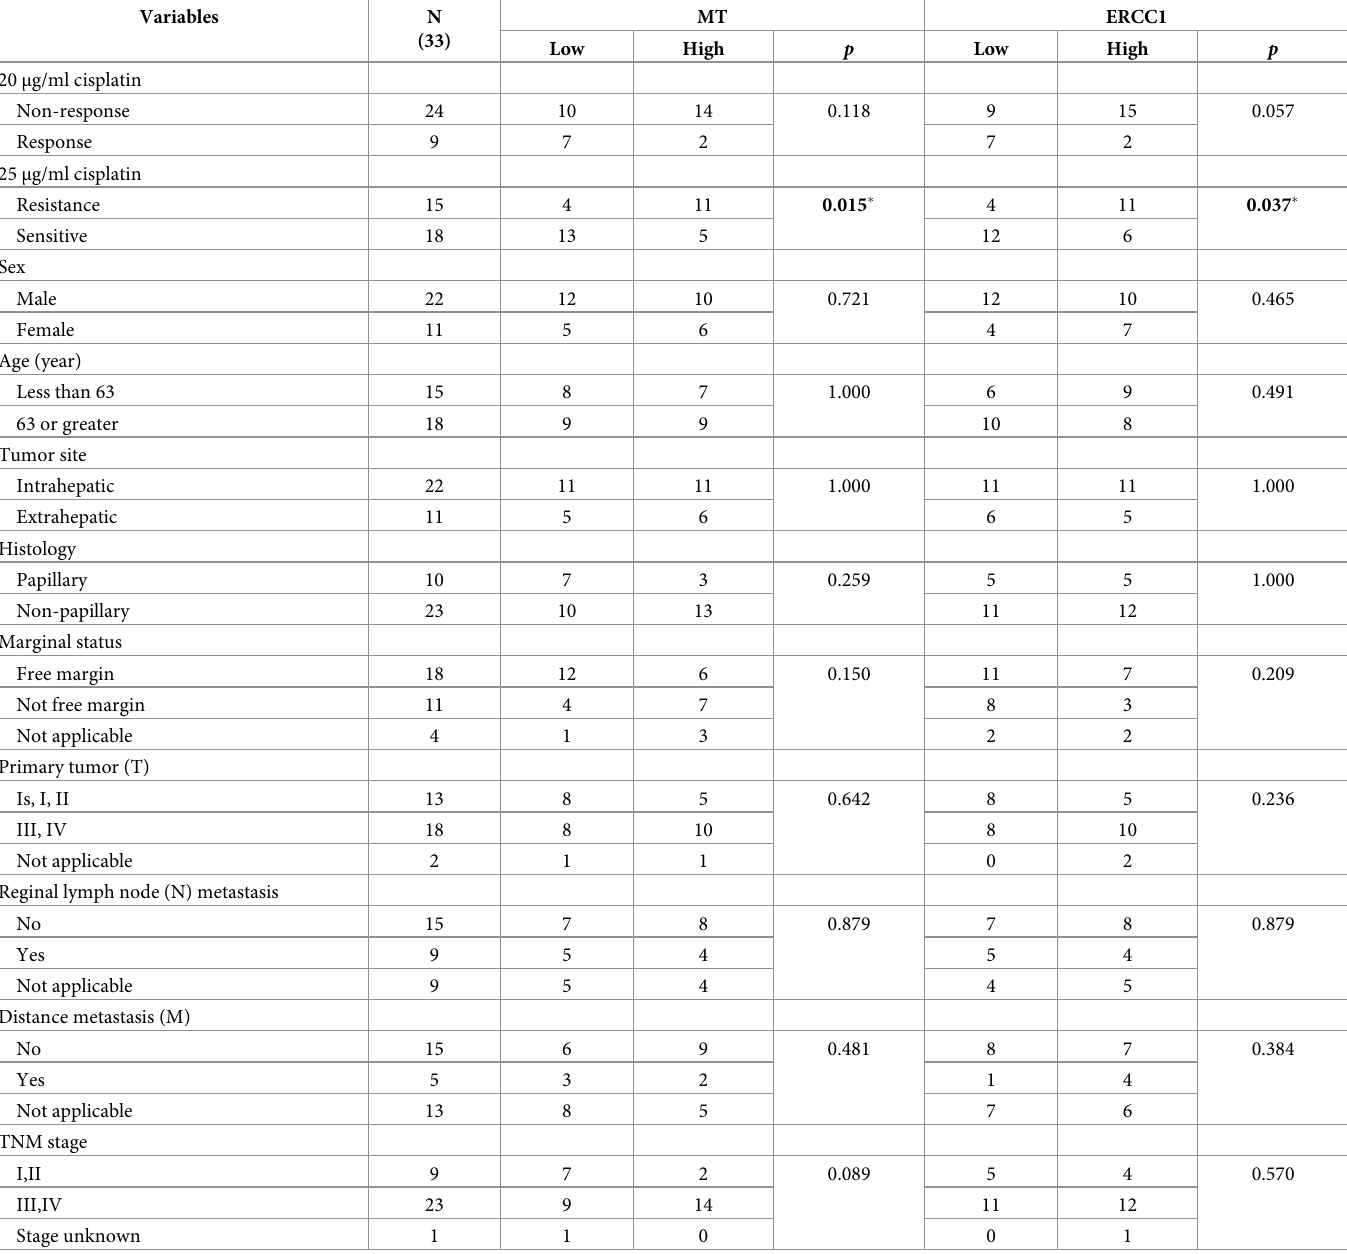
Table 6. Correlation of the expression of MT and ERCC1 with the drug response pattern using HDRA and the clinicopathological data of CCA patients. Variables N